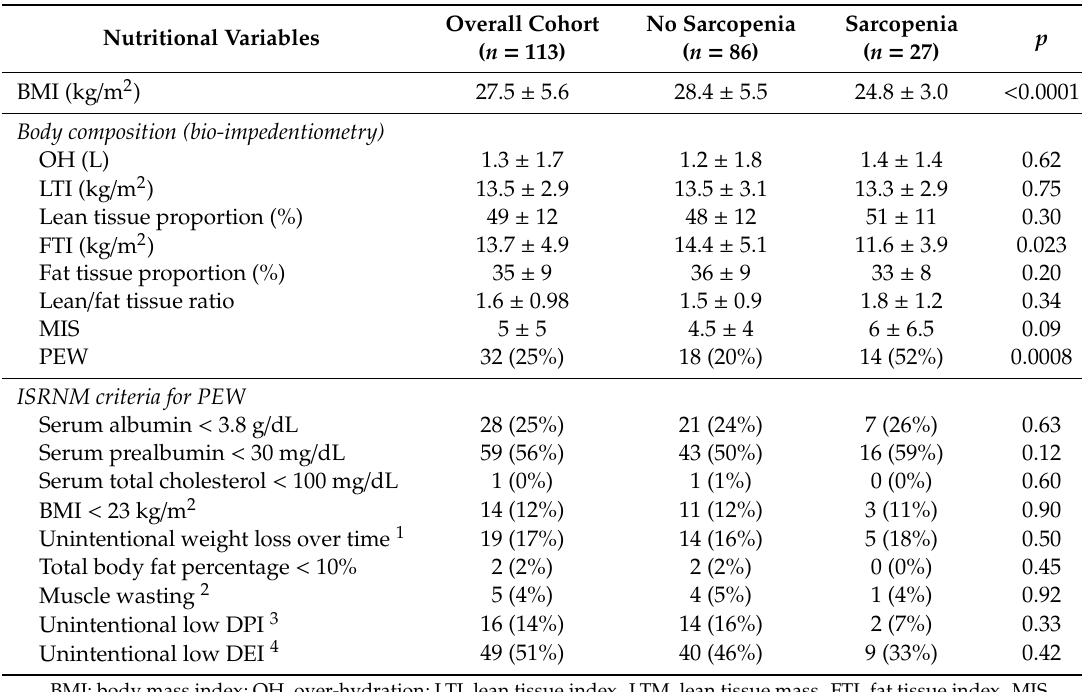
Table 3. Body composition and nutritional indices.